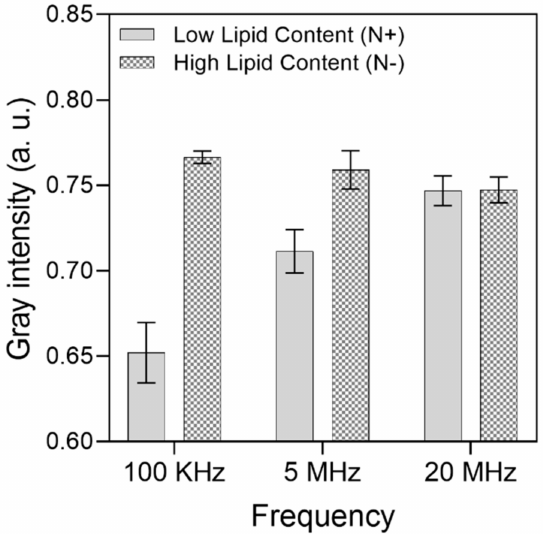
Figure 6. Gray intensity analysis of microalgae cell differentiation between high and low lipid content cells. A total of 256 gray values were considered from a range of 0 (black) to 1 (white). For HLC cells at 100 KHz, mean = 0.76 and standard deviation (SD.) = 0.003. For LLC cells at 100 KHz, mean = 0.65 and SD. = 0.01. For HLC cells at 5 MHz, mean = 0.75 and SD. 0.01. For LLC cells at 5 MHz, mean = 0.71 and SD. = 0.01. Finally, for HLC cells at 20 MHz, mean = 0.74 and SD. = 0.007. For LLC cells at 20 MHz, mean = 0.74 and SD. =